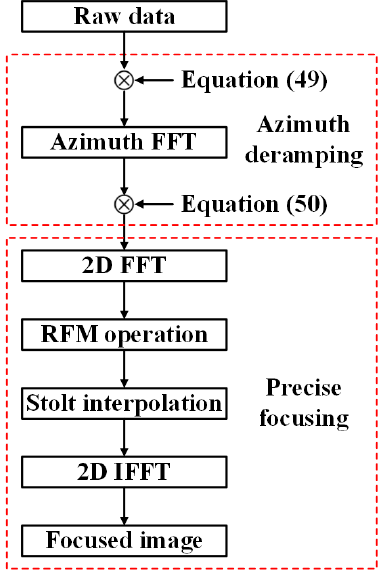
Figure 4. Flowchart of the proposed method.